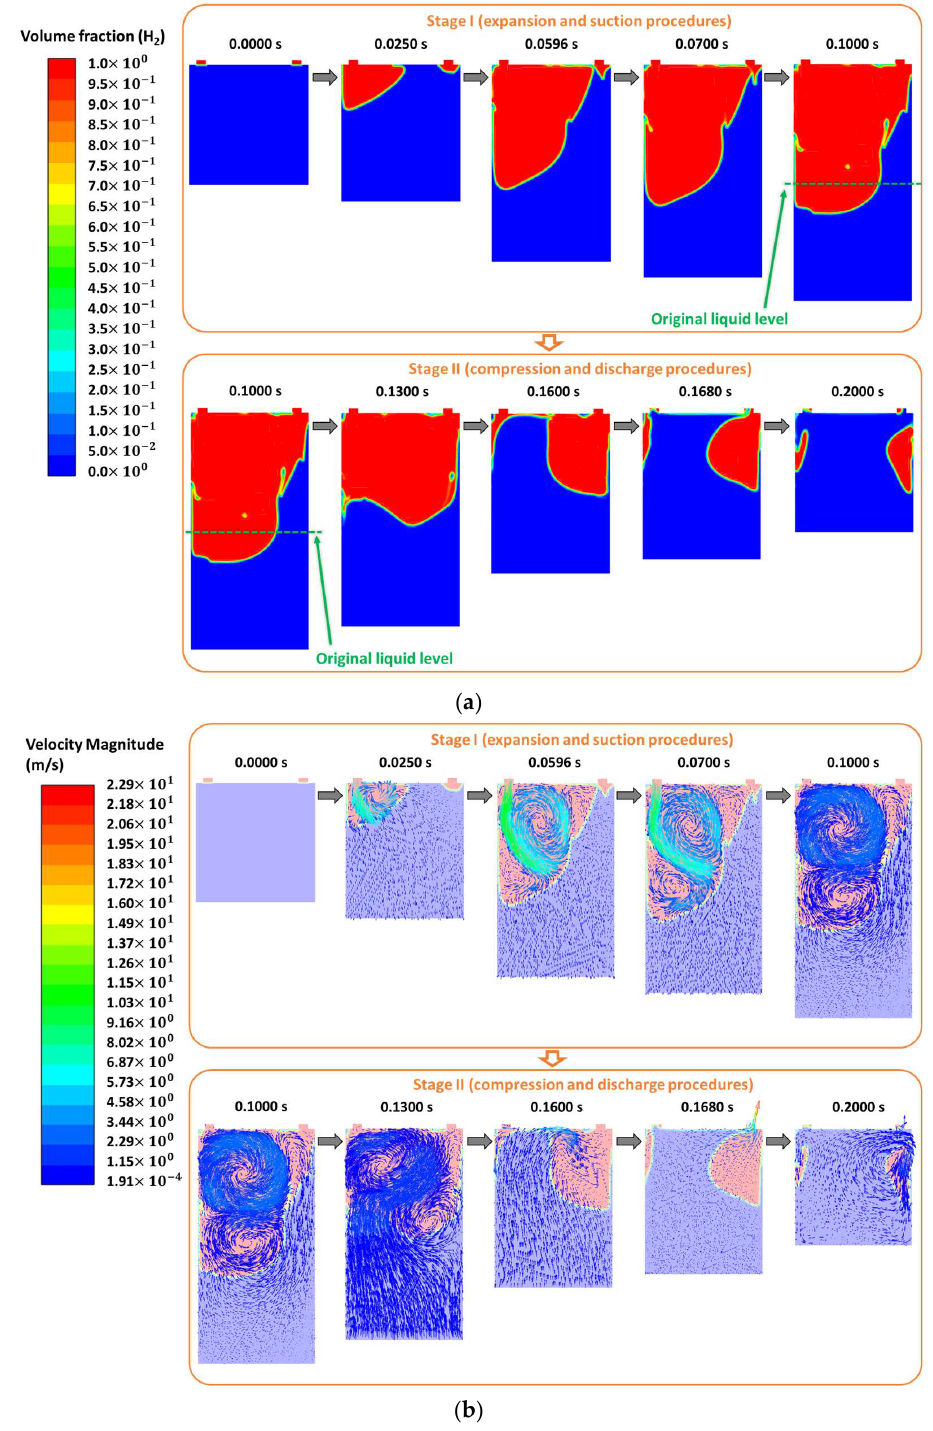
Figure 6. Results of the ( a ) volume fraction distribution and ( b ) velocity distribution (density of the ionic liquid: 1300 kg/m 3 ). ionic liquid: 1300 kg/m 3